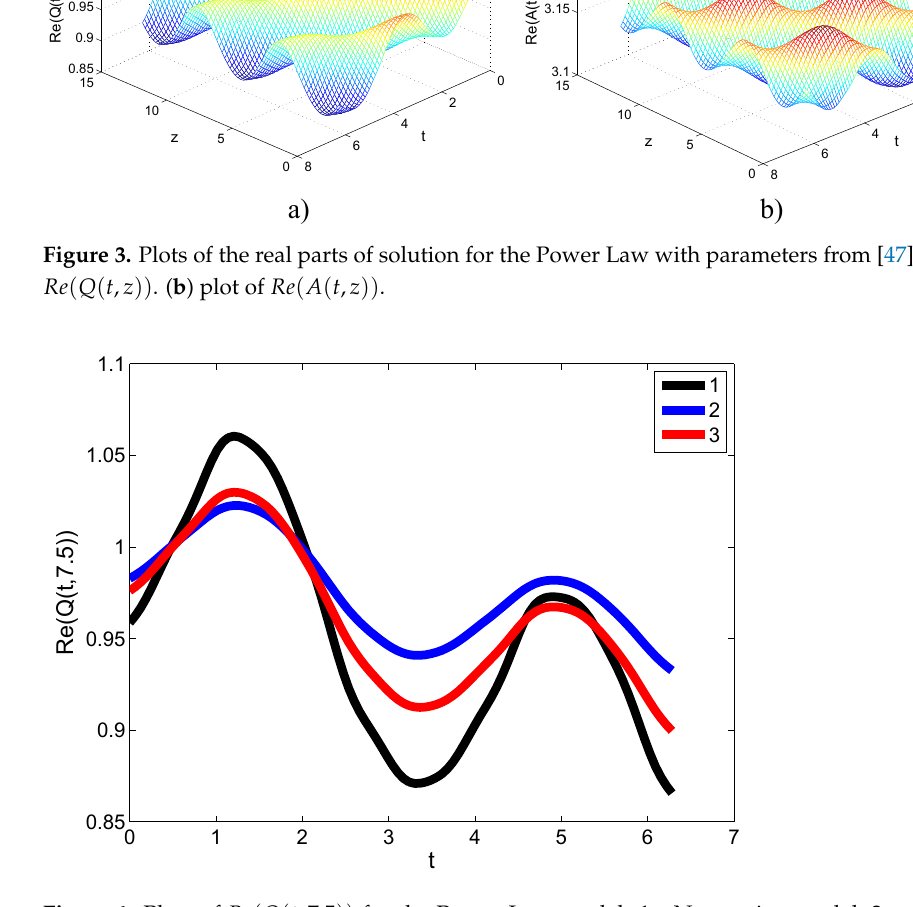
Figure 4. Plots of Re ( Q ( t ,7.5 )) for the Power Law model: 1—Newtonian model; 2—model with parameters from [46]; 3—model with parameters from